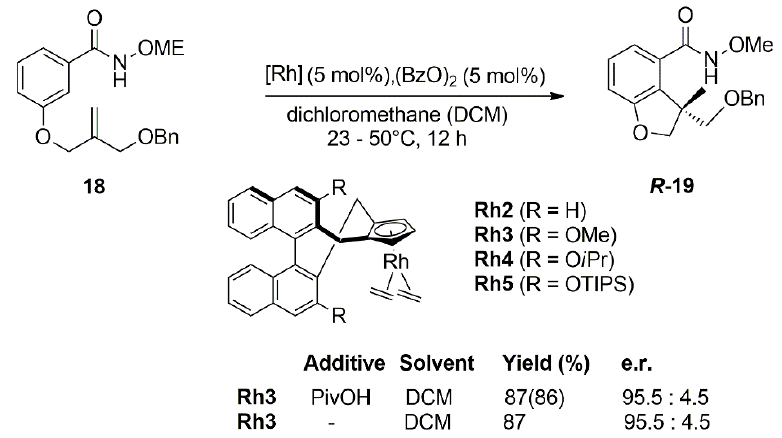
Figure 12 . Cpx Rhodium complexes in enantioselective hydroarylations of aryl hydroxamate 18.